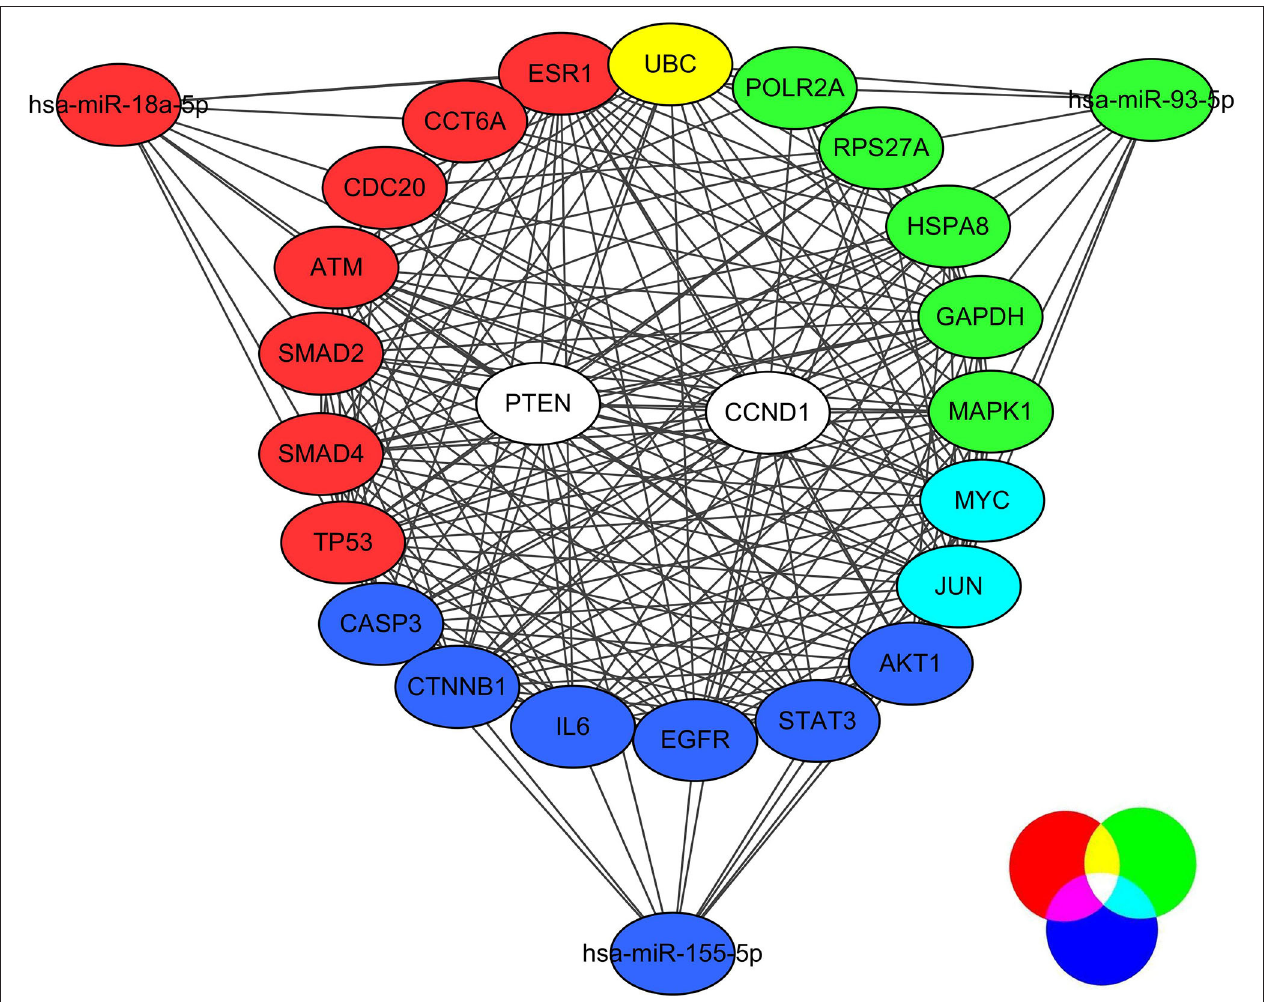
FIGURE 3 | The regulative network between three selected miRNAs and hub genes.